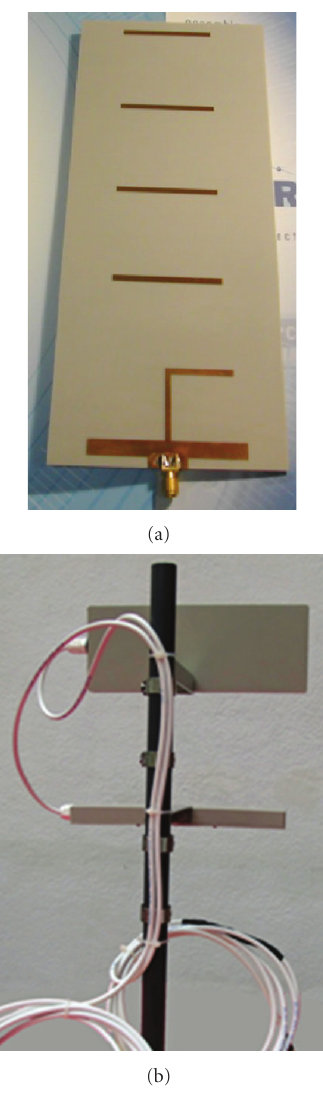
Figure 10: Photo of the printed dipole antenna with reflector and 4 directors.